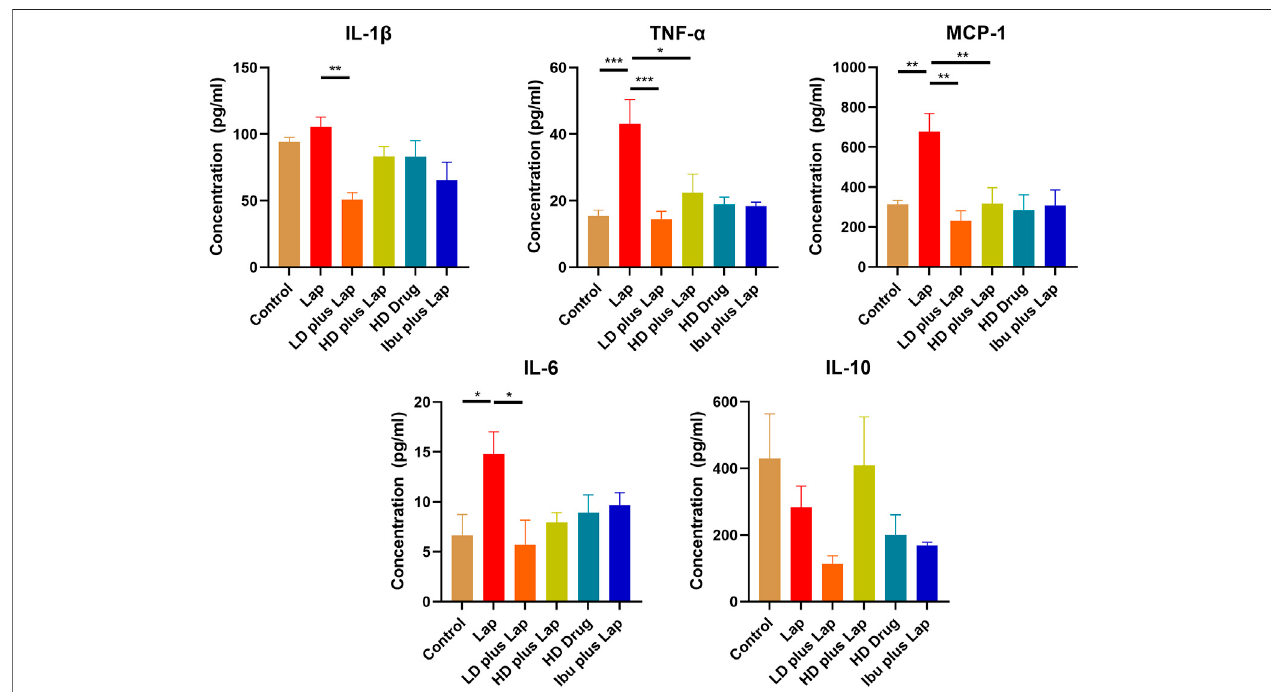
FIGURE 6 | D101 fraction reduced in fl ammatory cytokine expressions in the hippocampus of postoperative mice. Protein expression of different in fl ammatory cytokines in the hippocampus were examined. A signi fi cant increase in cytokines was observed in the hippocampus after surgery while inhibition of these cytokine expression was observed in D101 fraction treated group. Data are presented as the mean and SEM ( n = 4). * p < 0.05, ** p < 0.01, *** p < 0.001 compared with the laparotomy group. Values were analyzed by one-way ANOVA with Tukey post hoc